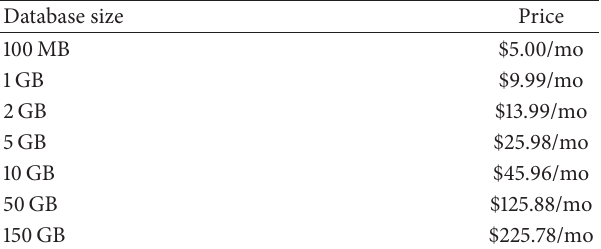
Table 5: Cloud database storage prices.